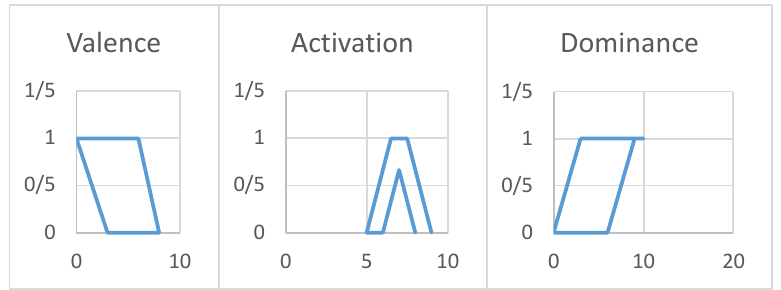
Fig. 5. The FOU of Obi Uto (Happiness) for dimensions valence, activation and dominance.